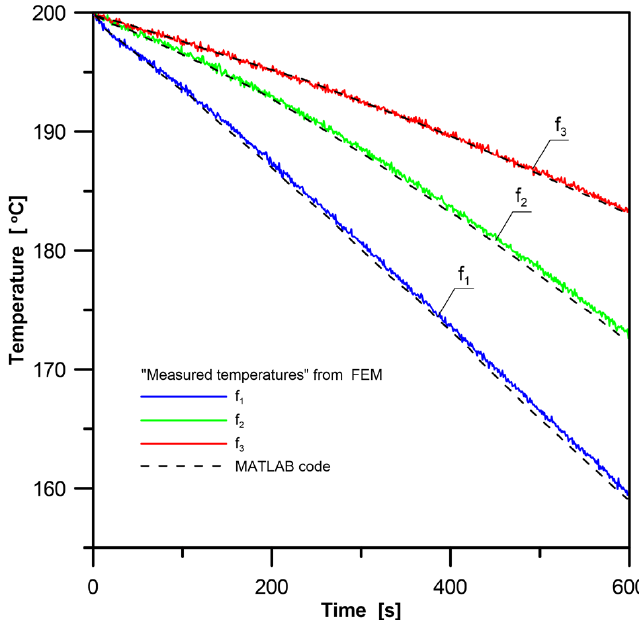
Figure 6. “Noisy measured data” generated by the FEM for the inverse solution and temperature transients form the MATLAB code.